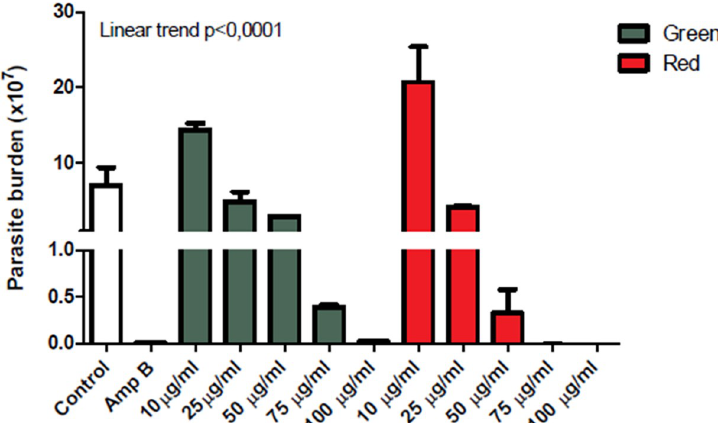
Fig 3. Reduction of the viability L . braziliensis promastigotes after treatment with extracts. Parasites were incubated with media alone or with ethanolic propolis extracts for 5 days. The viable parasites were counted daily with a Neubauer Chamber. The experiments were performed in quadruplicate for each experimental group ( � p < 0.05 and �� p < 0.01). Data are shown as mean +/- SD and are representative of two